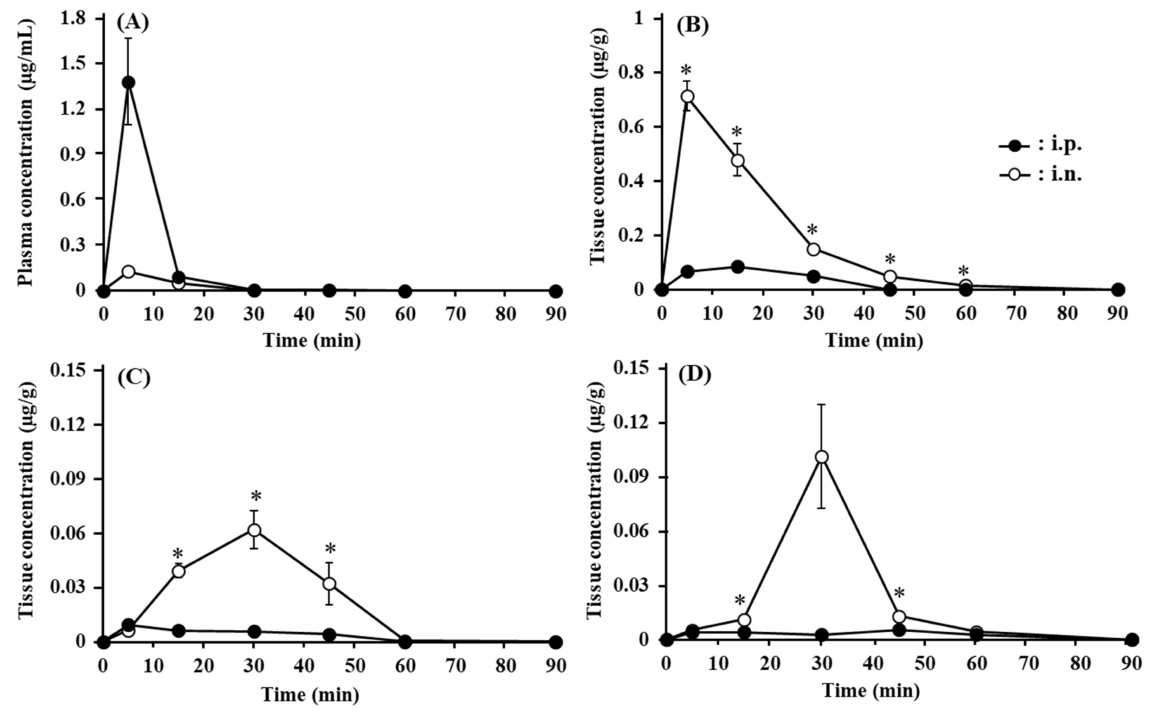
Figure 6. Changes in the concentrations of ANA-TA9 in ( A ) the plasma, ( B ) olfactory bulb, ( C ) frontal brain, and ( D ) Figure 1. Concentration profiles of ANA-TA9 in the plasma after ( A ) bolus intravenous injection and ( B ) constant intrave- occipital brain up to 90 min after intranasal and intraperitoneal application to mice. * p < 0.05 vs. i.p. Keys: • : i.p. and nous infusion. Keys: ● : bolus intravenous injection and ￮ : constant intravenous infusion. The results are expressed as the mean ± SE of three